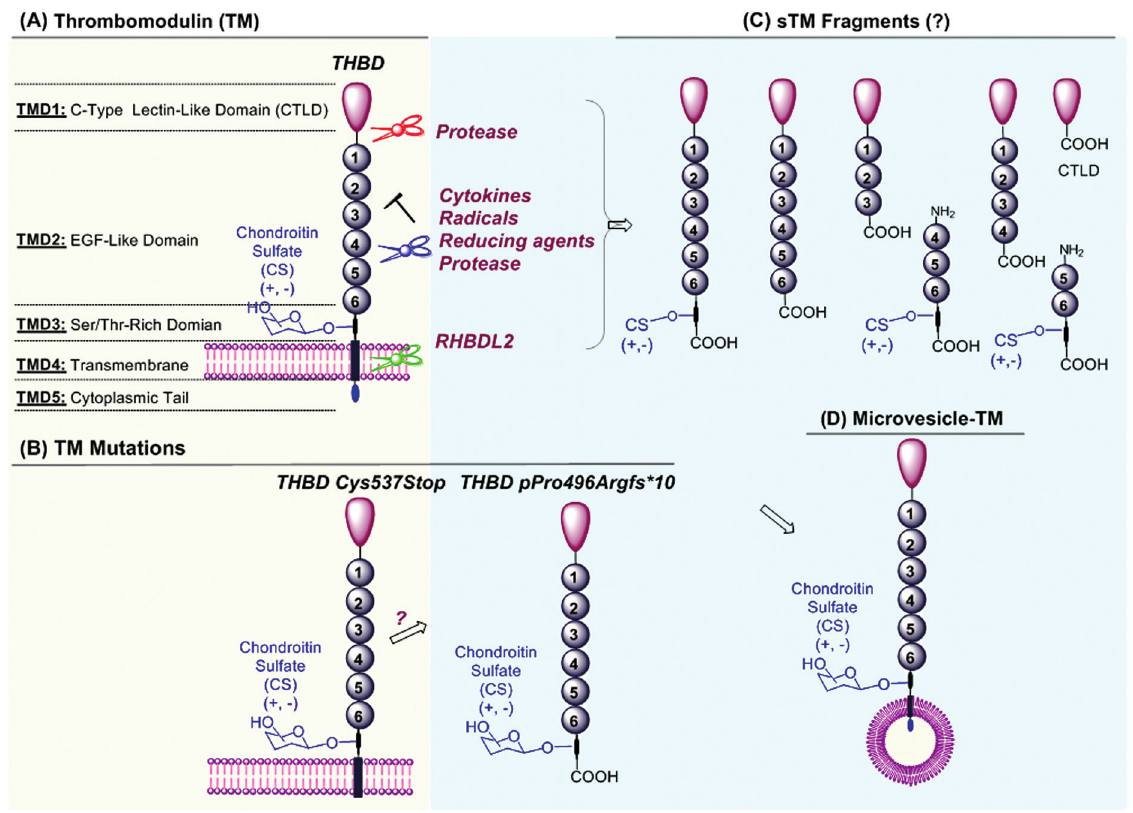
Fig. 1 Schematic presentation of structural domains of membrane thrombomodulin (TM) (A) and TM mutations (B) , its release mechanisms of predicted sTMs with corresponding domains (C), and microvesicle-TM (C) . CS, chondroitin sulfate; CTLD, C-type lectin-like domain; EGF, epidermal growth factor; RHBDL2, the intramembrane protease rhomboid-like-2; Ser, serine; sTM, soluble thrombomodulin; Thr,